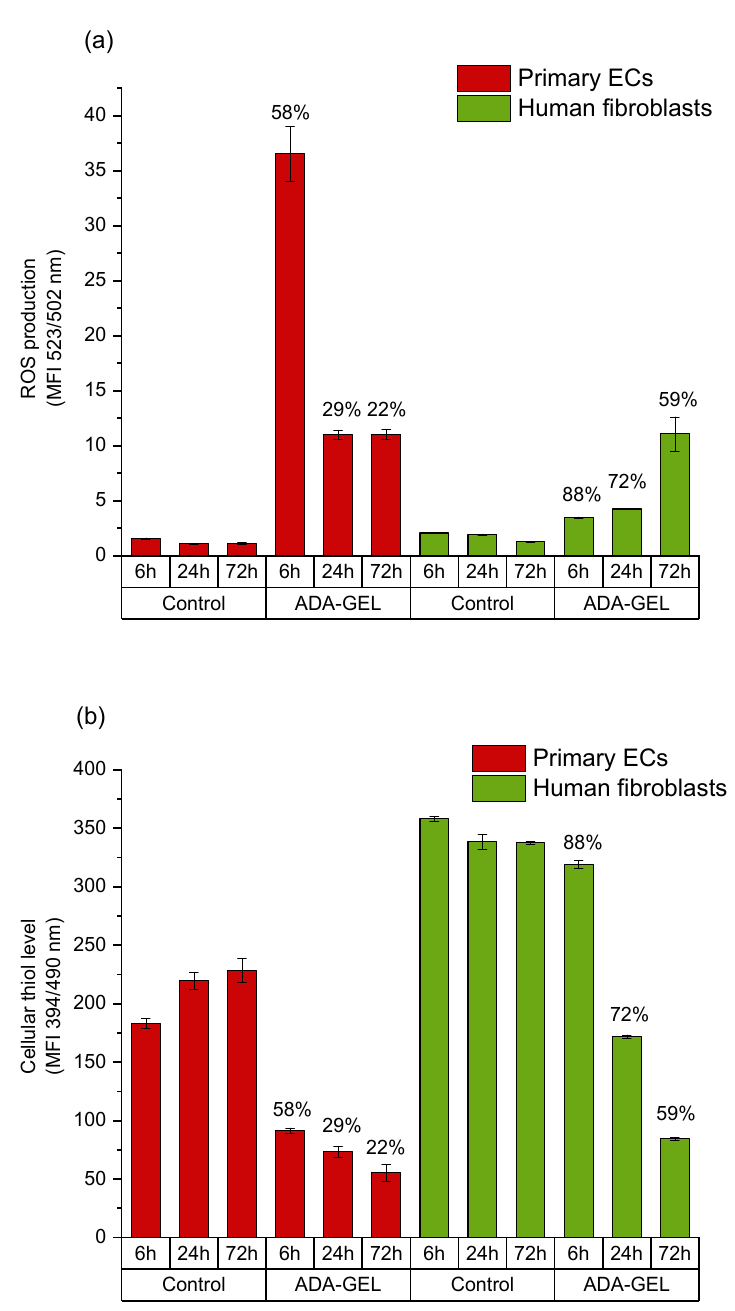
Figure 7. Comparison of intracellular ROS levels and cellular thiol levels in primary ECs and fibroblasts grown in a time dependent manner in ADA-GEL. ( a ) Mean value of DCF emission detected by flow cytometer; ( b ) intracellular thiol content of cells under the same conditions. Results obtained in the same cell population with MBB staining and mean value of emission are presented. Cell viability at respective time points is indicated over the columns. Control: cells with DCFH-DA grown on cell culture plastic.